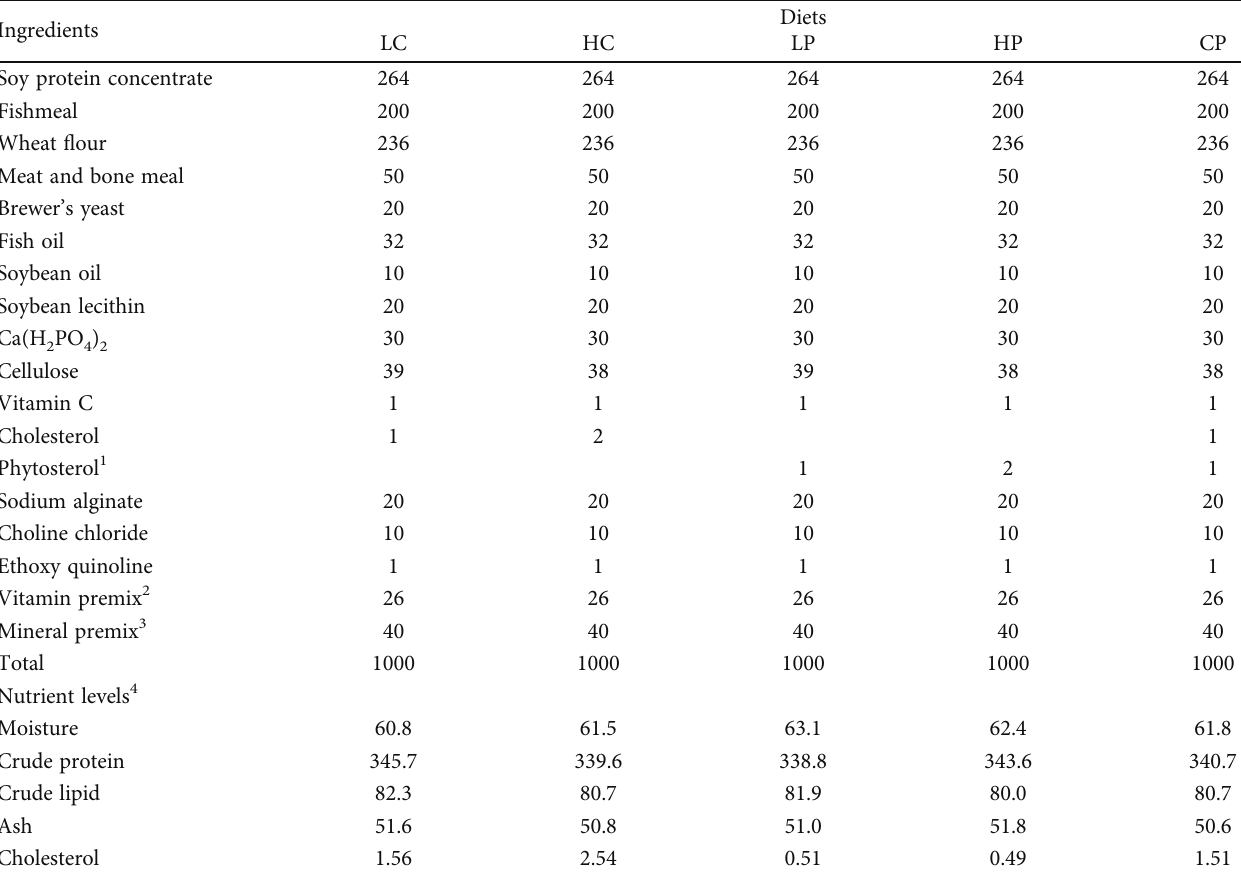
Table 1: Composition and nutrient levels of diets (dry basis